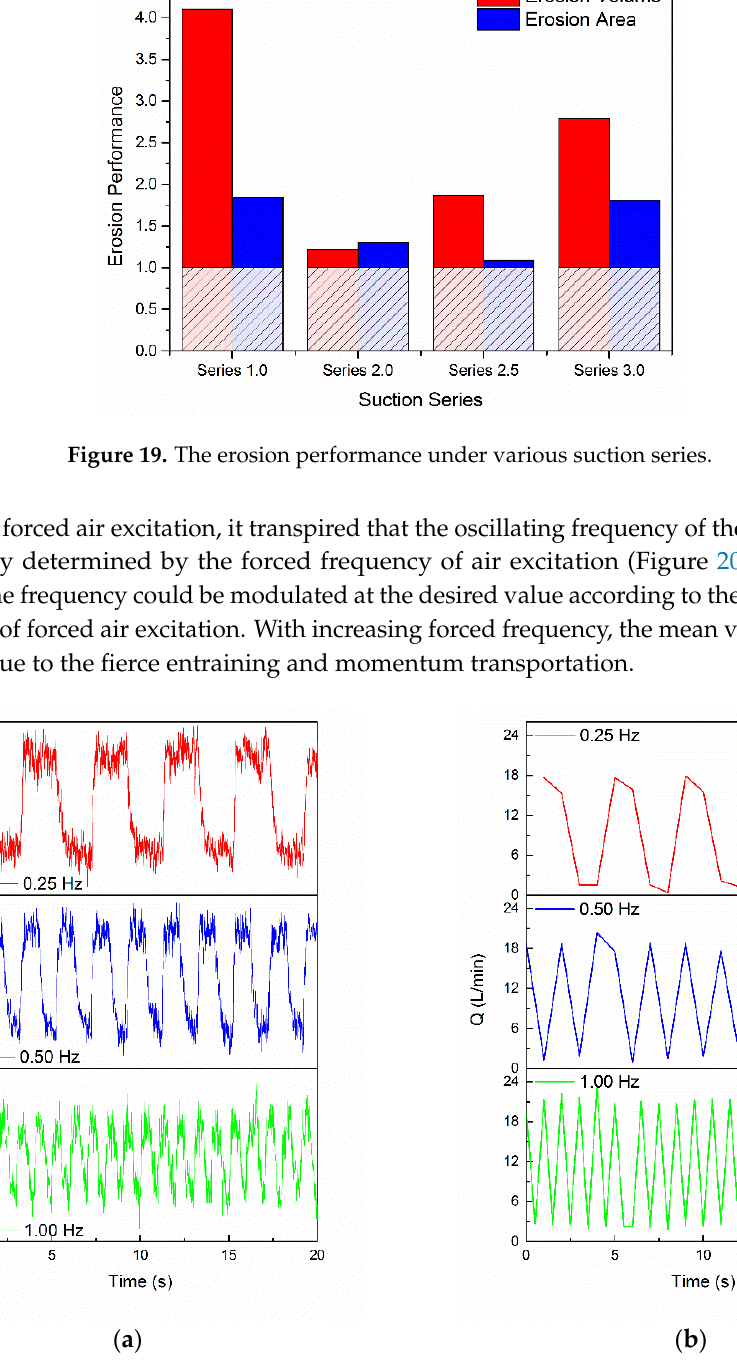
Figure 20. Time ‐ resolved signals under forced excitation: ( a ) chamber pressure and ( b ) volume of entrained air.